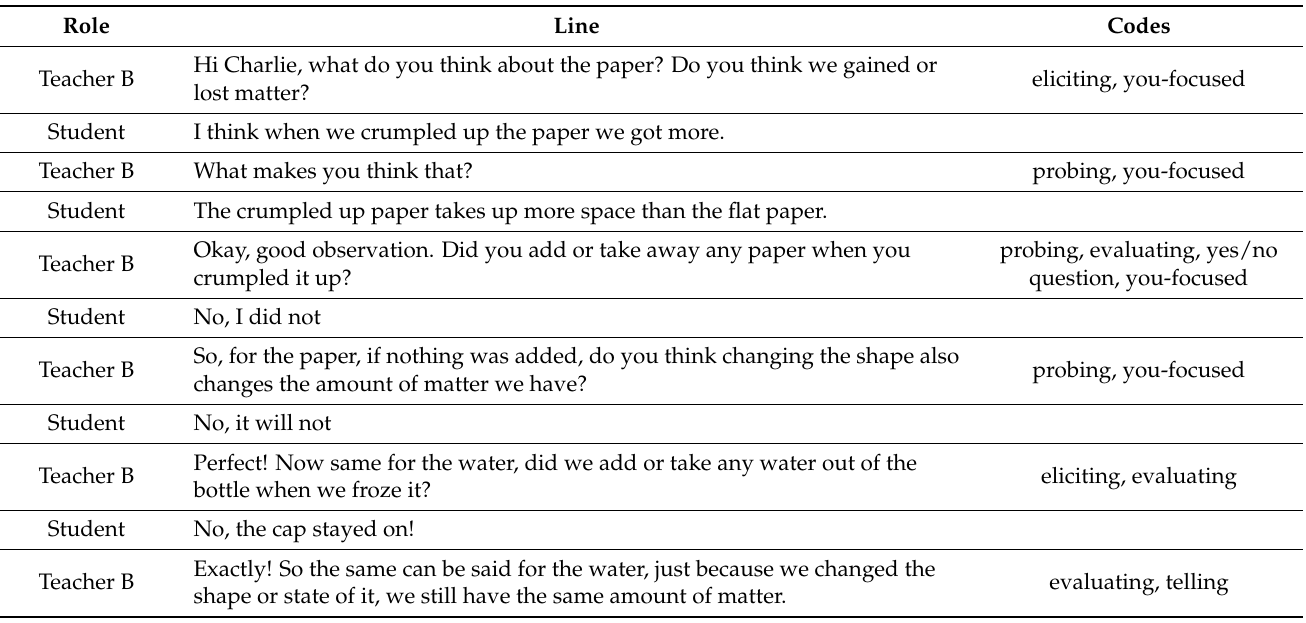
Table 7. Example conversation with more counterproductive than productive questioning strategies.